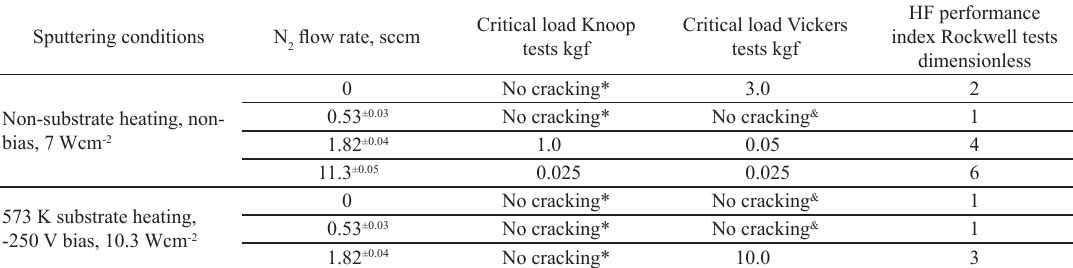
Table 2. Effects of sputtering conditions on critical loads for inducing formation of cracks under Knoop and Vickers indentations, and HF performance index £ for samples tested under Rockwell indentations. Sputtering